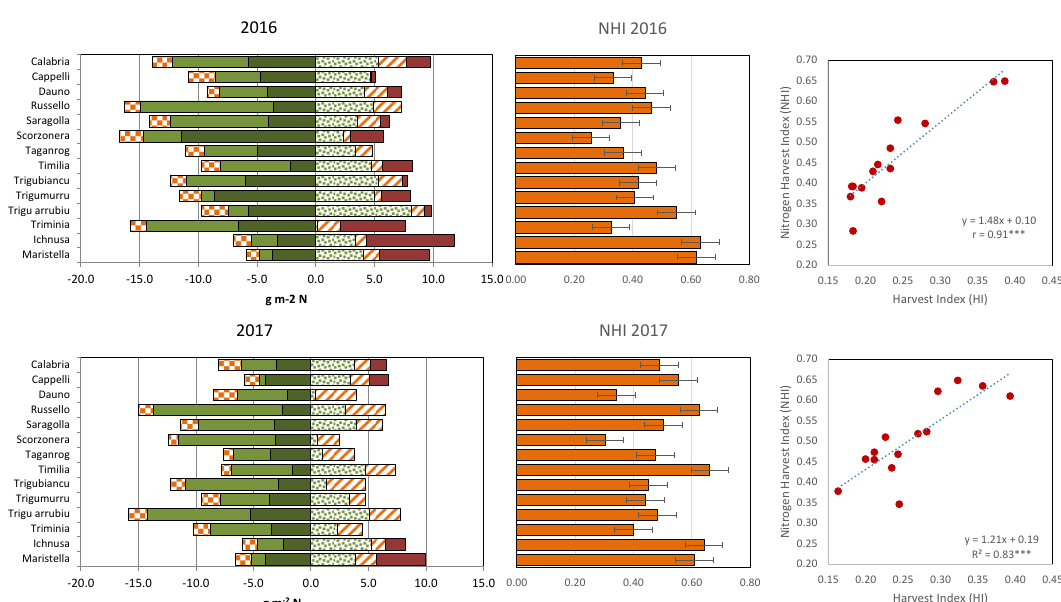
Figure 4. Left panel: N present in the crops at maturity. Negative values on the left-hand side of the y-axis are the amount of N remaining in the chaff (red-squared bars) and straw (green bars, with dark green representing the estimated structural N) at maturity. Positive values on the right-hand side of the y-axis, are the amount of N remobilised post-anthesis to the grain from the vegetative tissues (stems + leaves, green points) and from the ears (diagonal red lines), and the post-anthesis N uptake (red bars). Central panel: Nitrogen Harvest Index with LSD 0.05 values for the comparison of cultivars; Right panel: relationship between NHI and HI. Data are cultivars means in 2016 (upper row) and 2017 (lower row). ***, Pearson correlation coefficient significant at p ≤ 0.001.